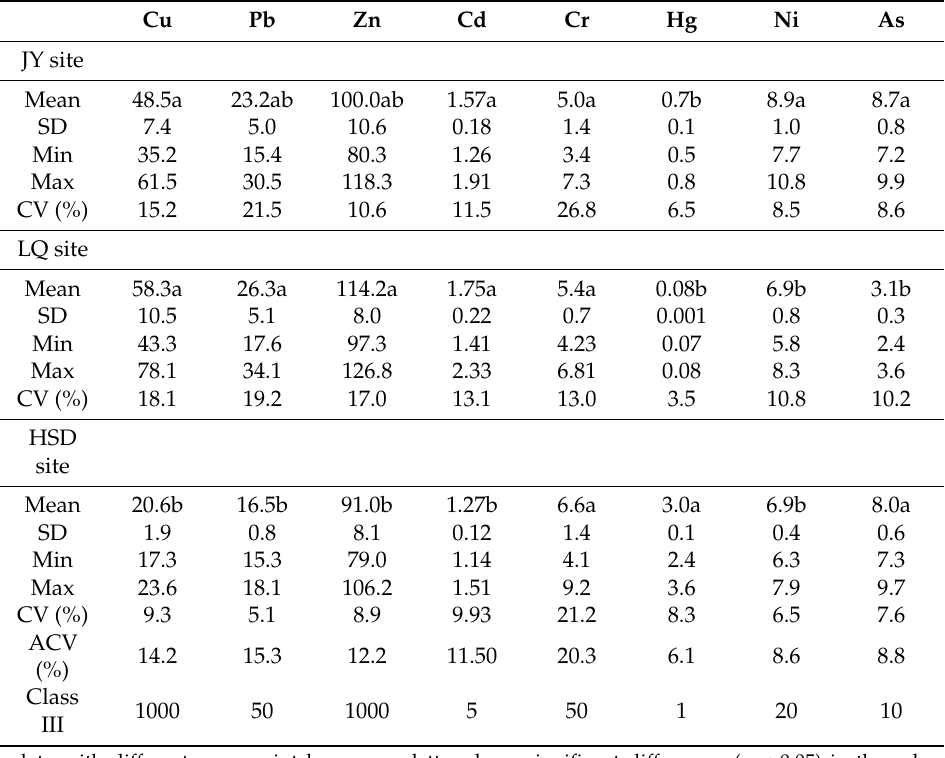
Table 2. Descriptive statistics of heavy metal concentrations ( µ g L − 1 ) in groundwater of turfy swamps. Cu Pb Zn